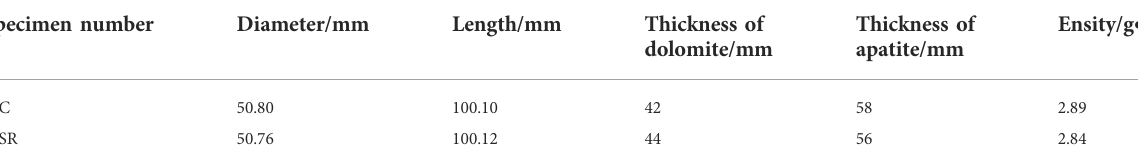
TABLE 3 Dimensions and density of the veri fi cation-test specimens.